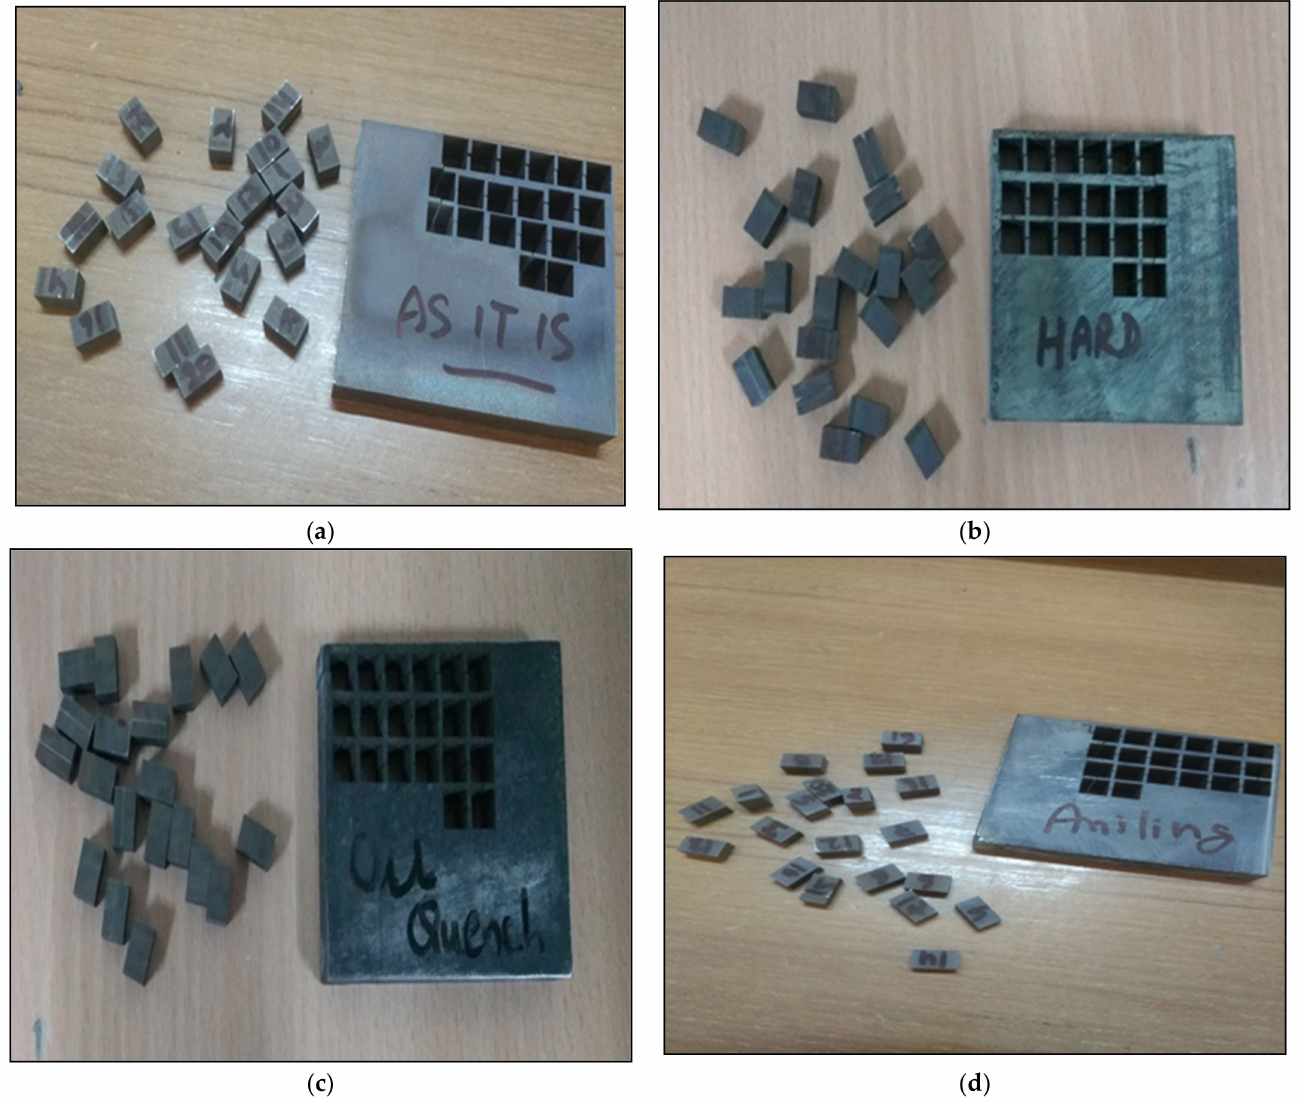
Figure 4. Actual samples cut using the wire EDM process. ( a ) Heat Treated Titanium Alloy as Received, ( b ) Hardening Heat treated Titanium Alloy, ( c ) Quenching Heat treated Titanium Alloy, ( d ) Annealing Heat treated Titanium